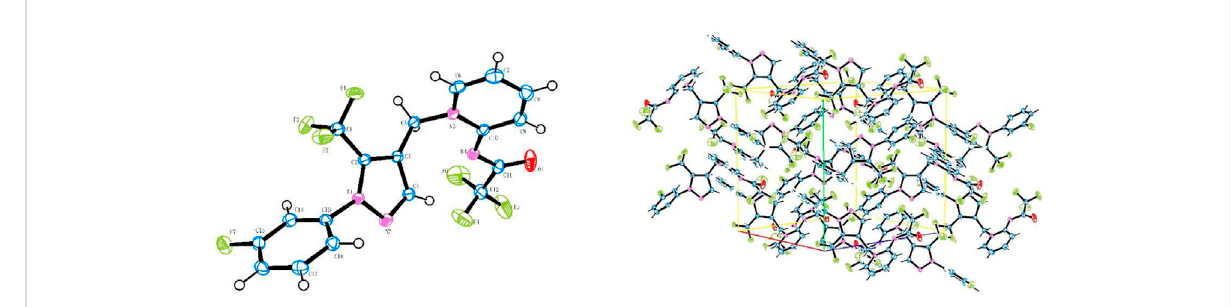
FIGURE 3 Crystal structure of compound A3 and the packing representation (CCDC number